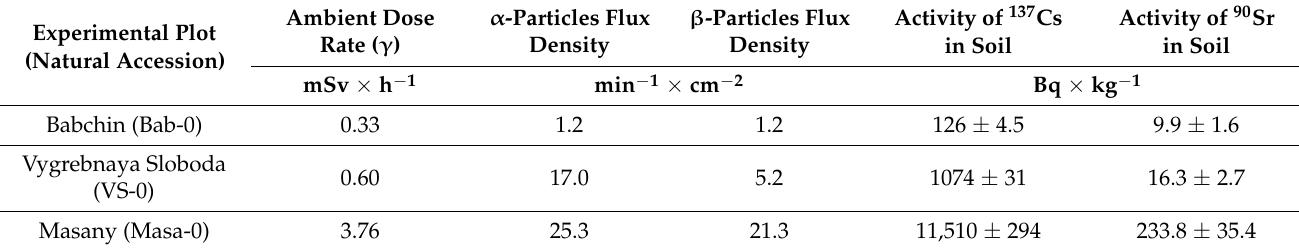
Table 2. The levels of radioactive contamination at the experimental plots. Experimental